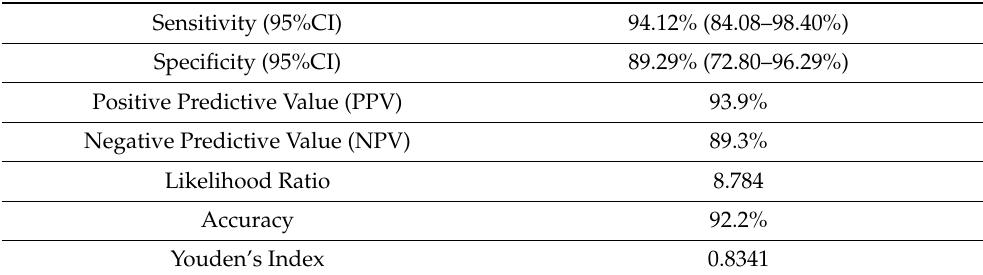
Figure 4. ROC analysis of FUT4 mRNA expression in the endometrium of women with endometriosis and control women. The area under the curve (AUC), standard error (SE), 95% confidence interval (95% CI), p -value and the total number of analyzed samples ( n ) are given in an inset. Table 2. Diagnostic value of FUT4 mRNA expression in the eutopic endometrium to predict endometriosis.